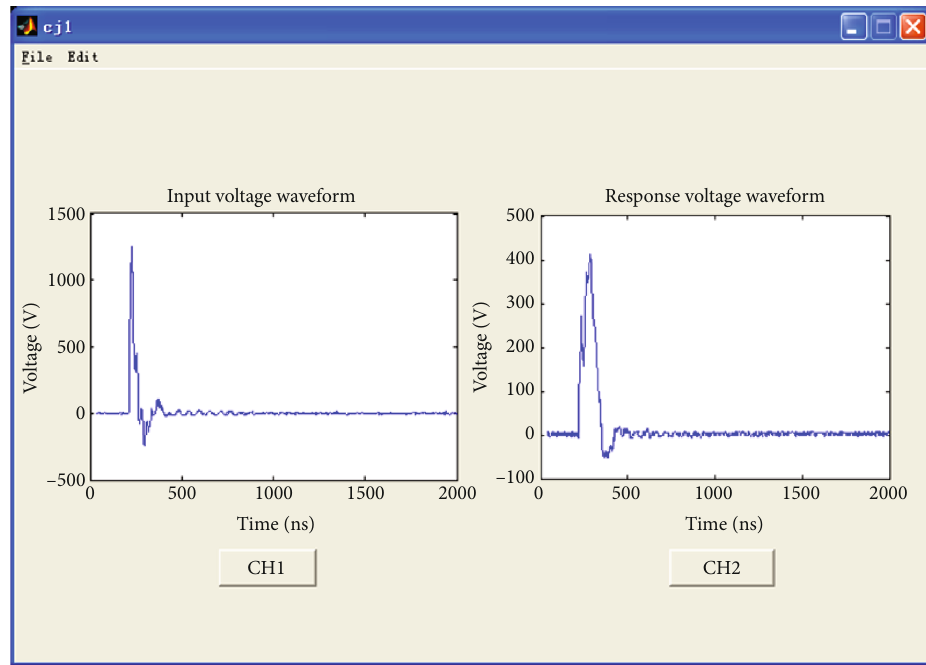
Figure 6: Response waveform of TVR20621 to narrow pulse.